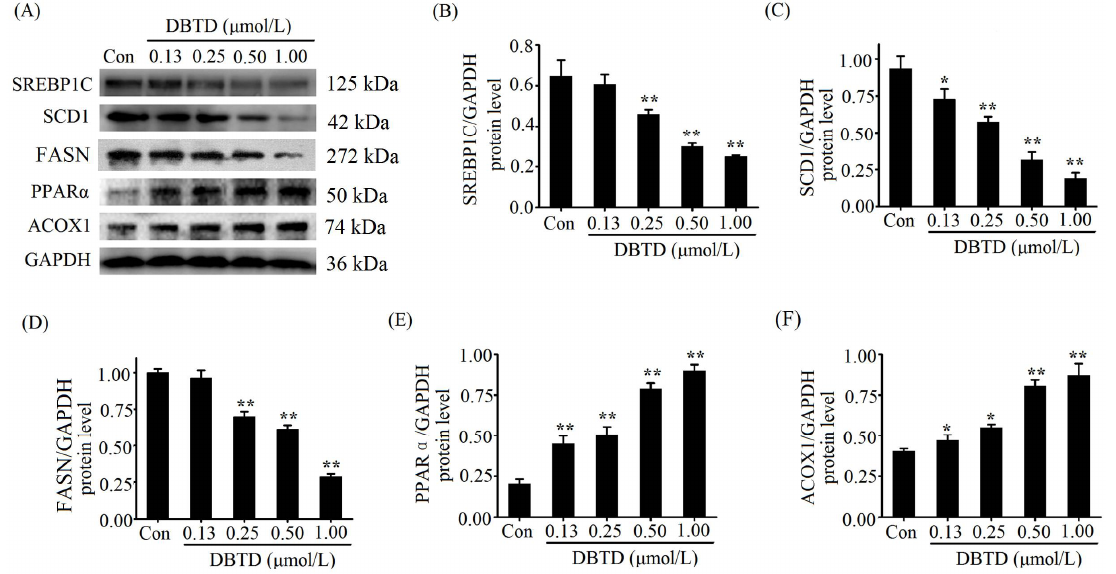
Figure 5. Western blot analysis of SREBP1C, SCD1, FASN, PPAR α , and ACOX1 in HL7702 cells treated with 0, 0.13, 0.25, 0.50, and 1.00 µ mol/L DBTD for 24 h. ( A ) Representative bands of relevant proteins. Relative protein levels of ( B ) SREBP1C, ( C ) SCD1, ( D ) FASN, ( E ) PPAR α , and ( F ) ACOX1 in liver cells treated with DBTD. Quantities are expressed as relative intensities against GAPDH. Data are presented as the mean ± SD of three experiments. * p < 0.05 and ** p < 0.01 versus control.